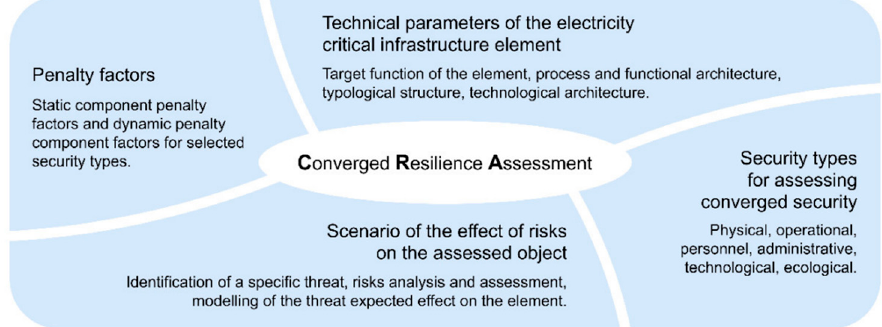
Figure 1. Depiction of Converged Resilience Assessment’s proposal